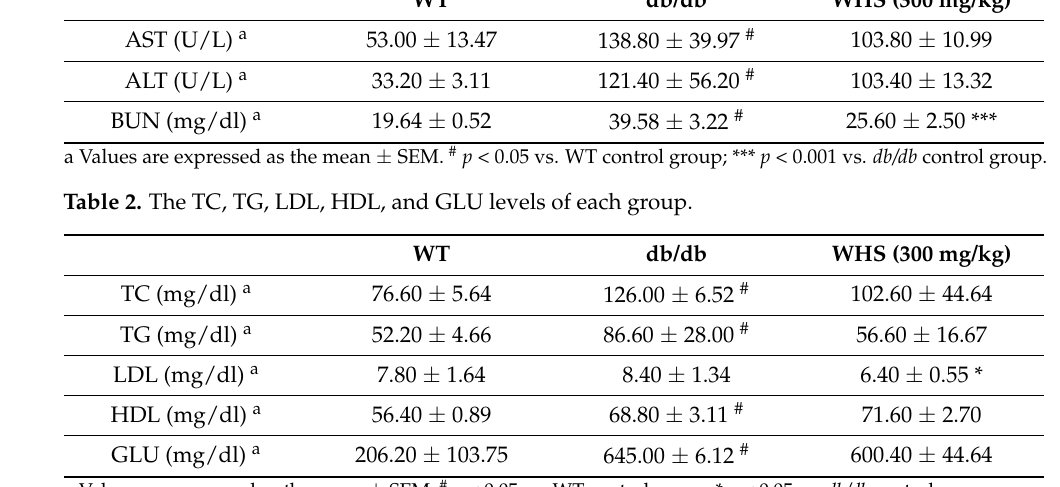
Table 1. The plasma AST, ALT, and BUN levels of each group. WT db/db WHS (300 mg/kg) AST (U/L) a